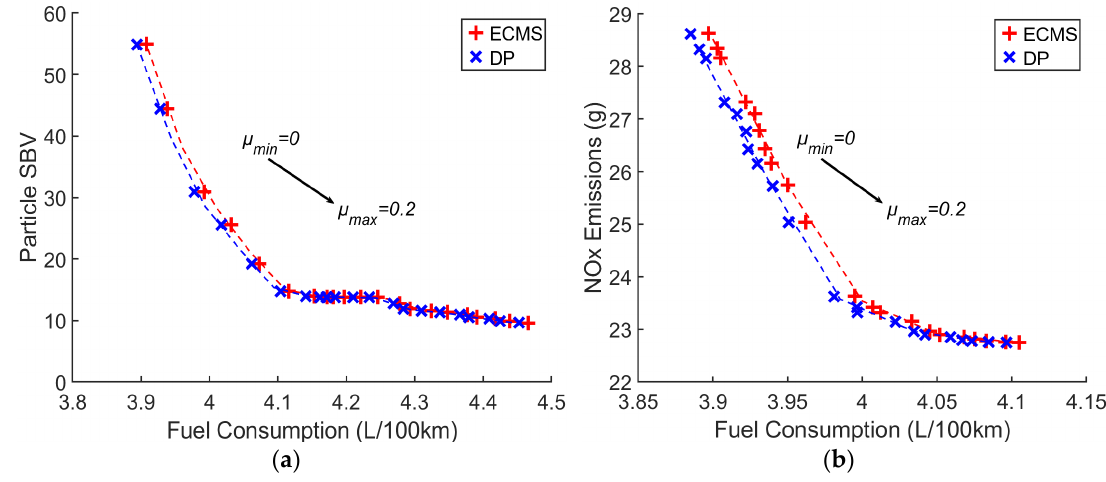
Figure 16. The comparison between simulation results of Dynamic Programming (DP) and Equivalent Consumption Minimization Strategy (ECMS): ( a ) Particle and ( b ) NOx.